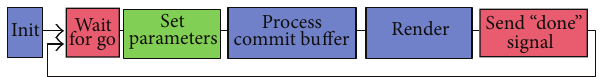
Figure 8: Tracer thread initialization and main